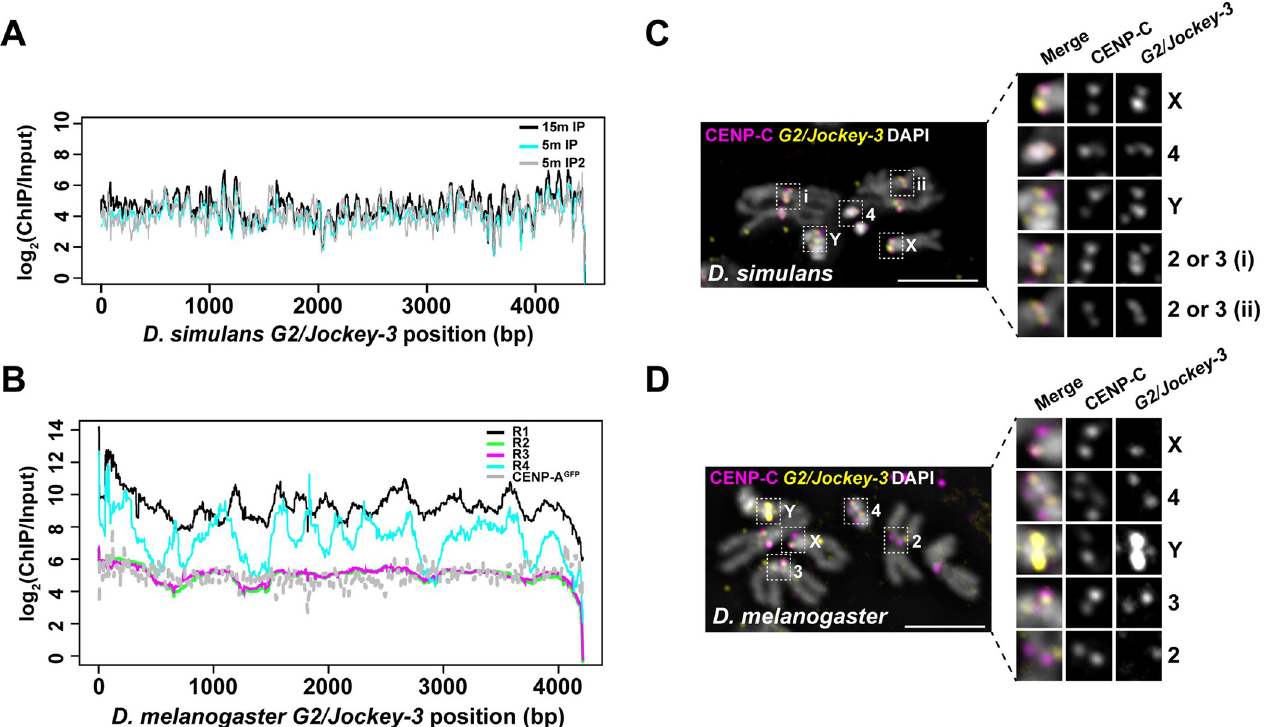
Fig 6. The association between G2/Jockey-3 and centromeres is conserved in D . simulans . (A) Plot of the normalized CENP-A enrichment over input across the D . simulans G2/Jockey-3 consensus sequence using CENP-A ChIP-seq data from D . simulans ML82-19a cells [16] showing that G2/Jockey-3 is enriched in CENP-A in D . simulans . The labels “15m” and “5m” indicate minutes of MNase digestion, and IP and IP2 are technical replicates. Note that the first 487 bp of D . simulans G2/Jockey-3 consensus sequence, which are homologous to the D . simulans 500-bp satellite, are not included in this figure; the 500-bp satellite was previously reported as enriched in CENP-A in D . simulans [16]. (B) Plot of the normalized CENP-A enrichment over input across the D . melanogaster G2/ Jockey-3 consensus sequence using our CENP-A ChIP-seq replicates (R1–R4) and ChIP-seq from CENP-A–GFP transgenic flies from Talbert and colleagues [16]. The underlying data for (A-B) can be found in S1 Data. IF-FISH on (C) D . simulans (w501) and (D) D . melanogaster (iso-1) mitotic chromosomes from male larval brains using an antibody for CENP-C (magenta) and FISH with a G2/Jockey-3 DIG-labeled FISH probe (yellow). DAPI is shown in gray. Bar 5 μ m. CENP-A, centromere protein A; CENP-C, centromere protein C; ChIP, chromatin immunoprecipitation; ChIP-seq, ChIP sequencing; DIG, digoxigenin; FISH, fluorescence in situ hybridization; GFP, green fluorescent protein; IF, immunofluorescence; IP, immunoprecipitation.